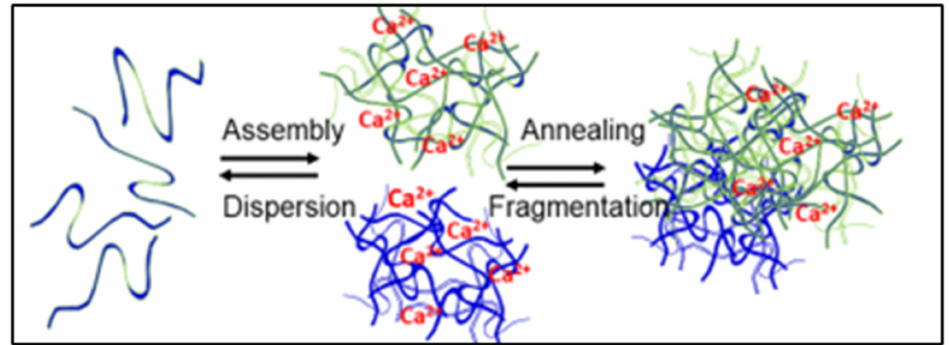
Figure 2. In MG formation are two equilibrium constants: one representing the reversible mass transfer between free polymers and nano-assembled networks, and another that report the dynamics of reversible interconnection resulting from reptation and interpenetration of polymers that result in the formation of MG